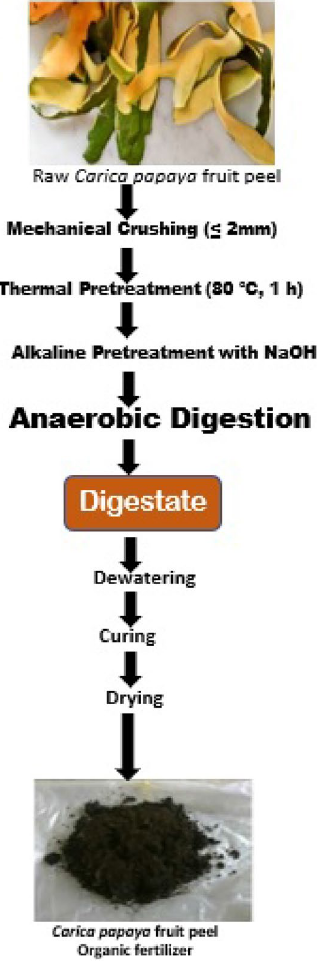
Figure 1. Pictorial representation of the organic fertilizer development